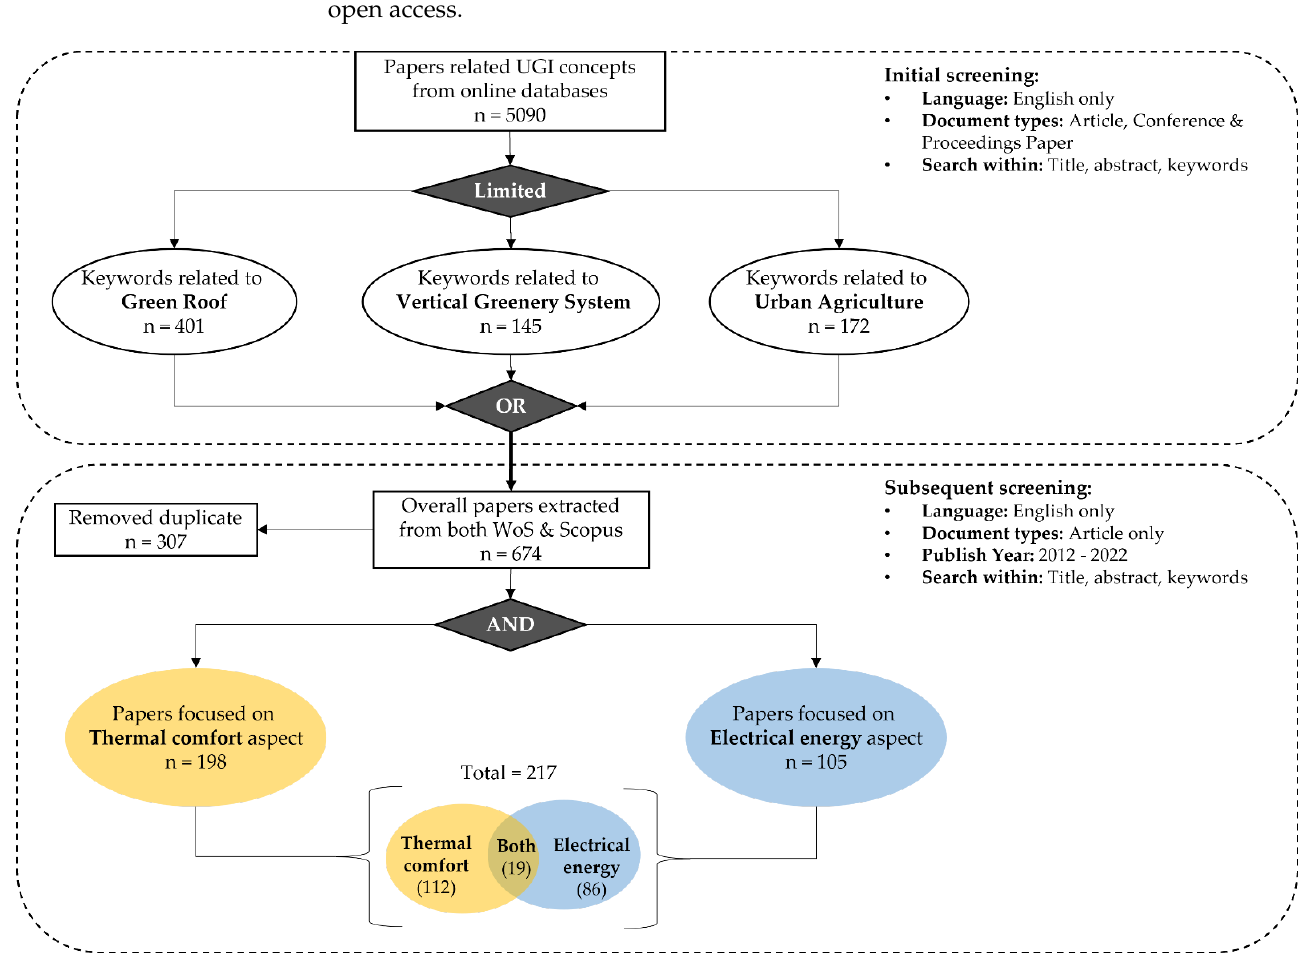
Figure 2. The workflow of the systematic